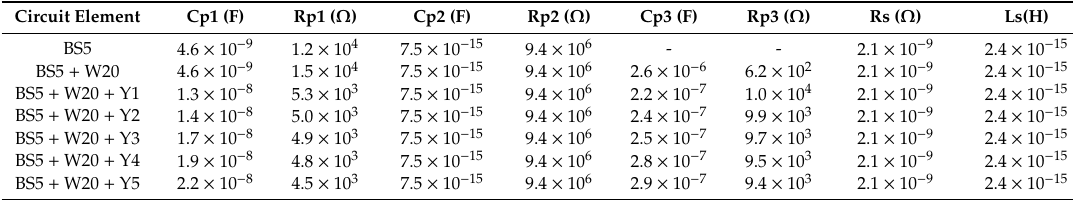
Table A2. Modeled impedance parameters Cp1, Rp1, Cp2, Rp2, Cp3, Rp3, Rs, and Ls of biochip BS5, with DI water and S. cerevisiae. Circuit Element